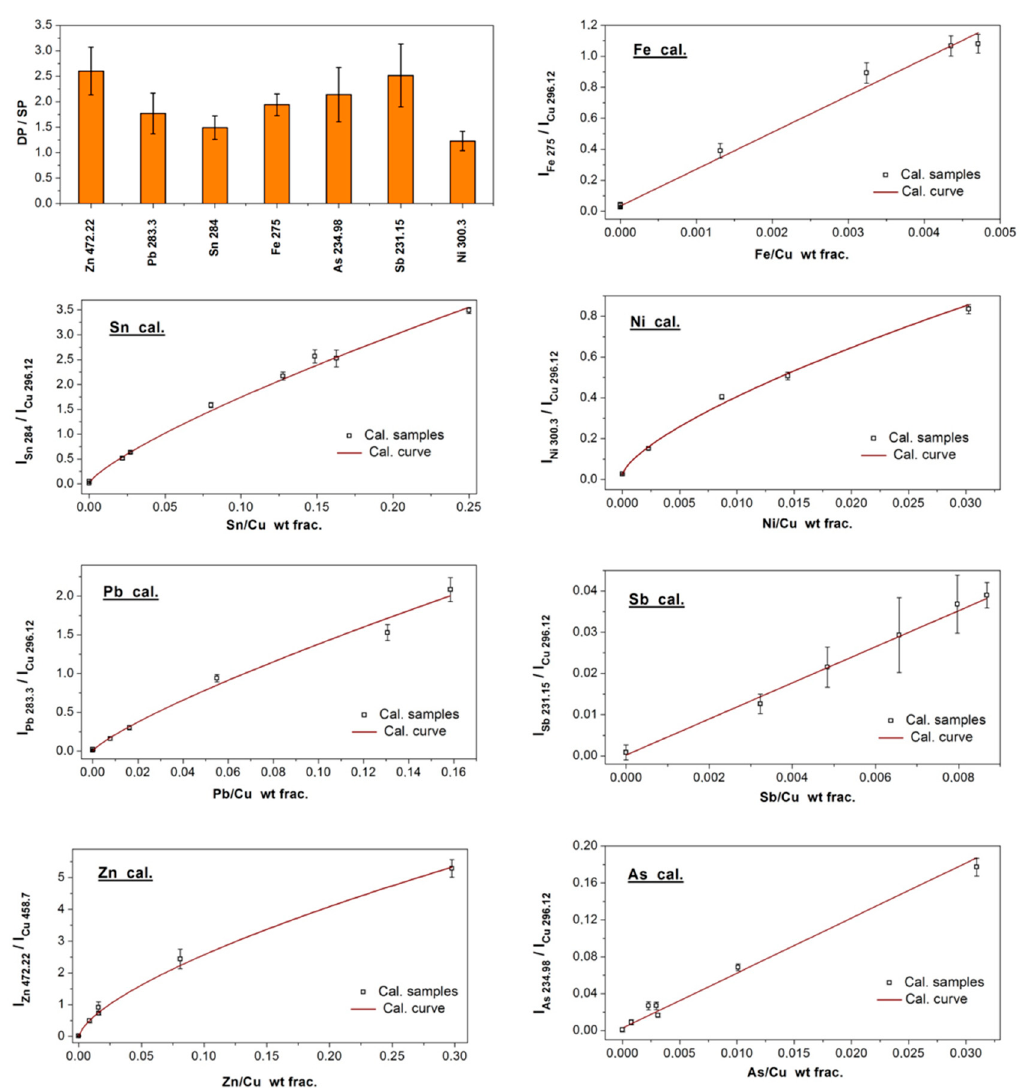
Figure 5. Top left: DPP enhancement factor in config. 1 for the atomic emission lines selected for calibration. The other panels show the calibration curves obtained in config. 1 for the quantification of Sn, Pb, Zn, Fe, Ni, Sb, and As in copper alloys. Sn: y = 0.012 + 10.4 x 0.78 (R 2 = 0.99), Pb: y = 8.9 x 0.81 (R 2 = 0.85), Zn: y = 12 x 0.67 (R 2 = 0.98), Fe: y = 0.035 + 237 x (R 2 = 0.98), Ni: y = 0.026 + 9.8 x 0.71 (R 2 = 0.99), Sb: y = 0.005 + 4.38 x (R 2 = 0.99), As: y = 0.003 + 5.97 x (R 2 = 0.96). Acquisition delay of 1.3 µs, integration time of 2 ms, SP ( ε sp = 90 mJ), config. 1 DP ( ε p2 = ε p1 = 85 mJ, Δτ p = 85 µs).